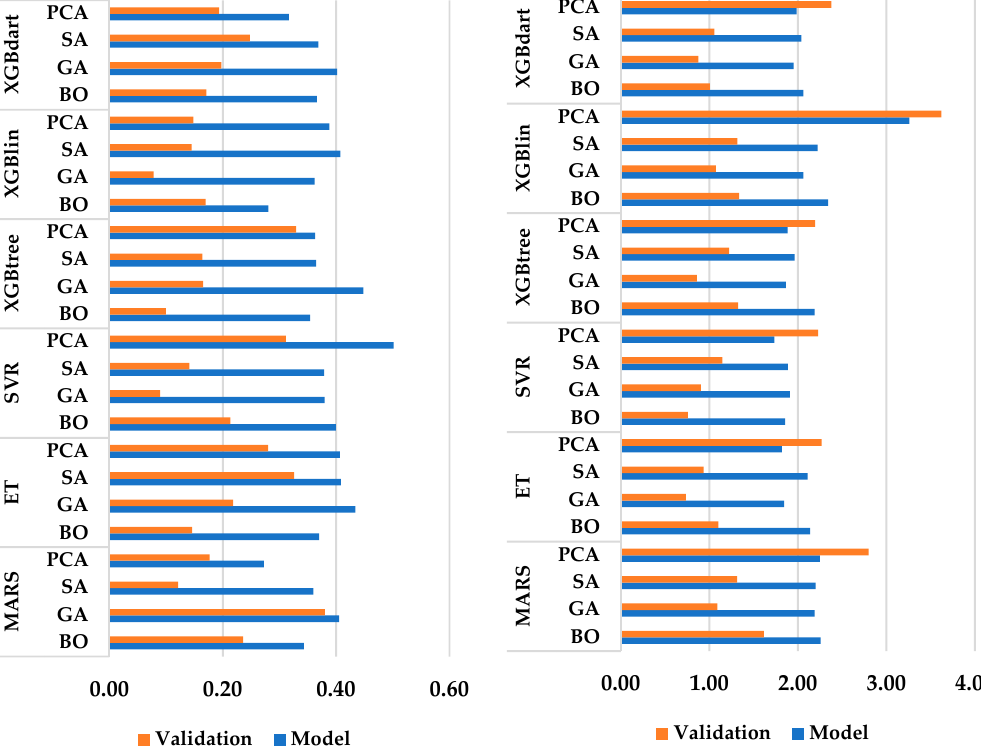
Figure 8. Machine learning model performance of R 2 ( left ) and RMSE ( right ) using input dataset from selected lidar